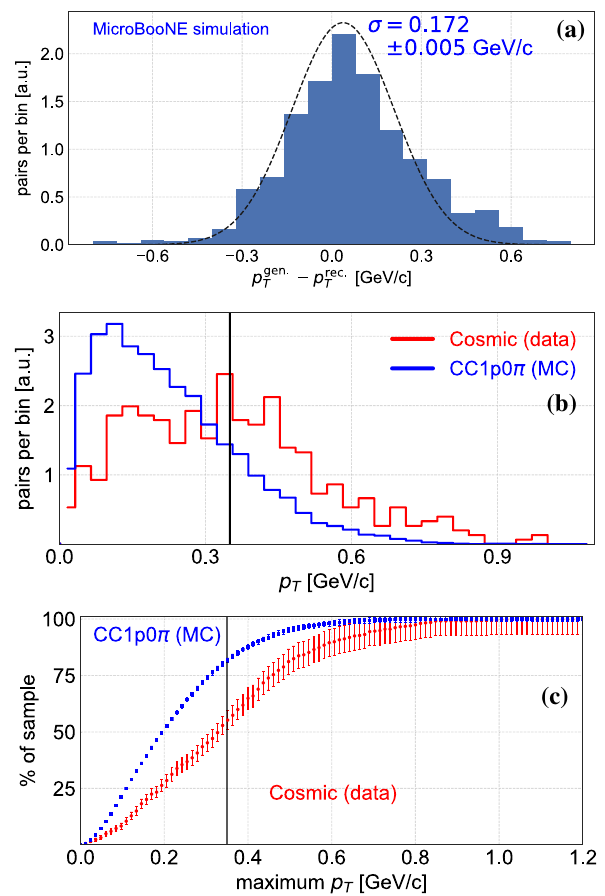
Fig. 10 a The difference between the reconstructed and generated (truth-level) p T , for simulated CC1 p 0 π signal events. A fit for a Gaus- sian distribution function around the peak is depicted in the figure, as well as the width σ of the best-fit result. b The distributions of the reconstructed p T between the two tracks, after the application of the detection selection criteria. c The effect of a selection criterion on the maximal reconstructed p